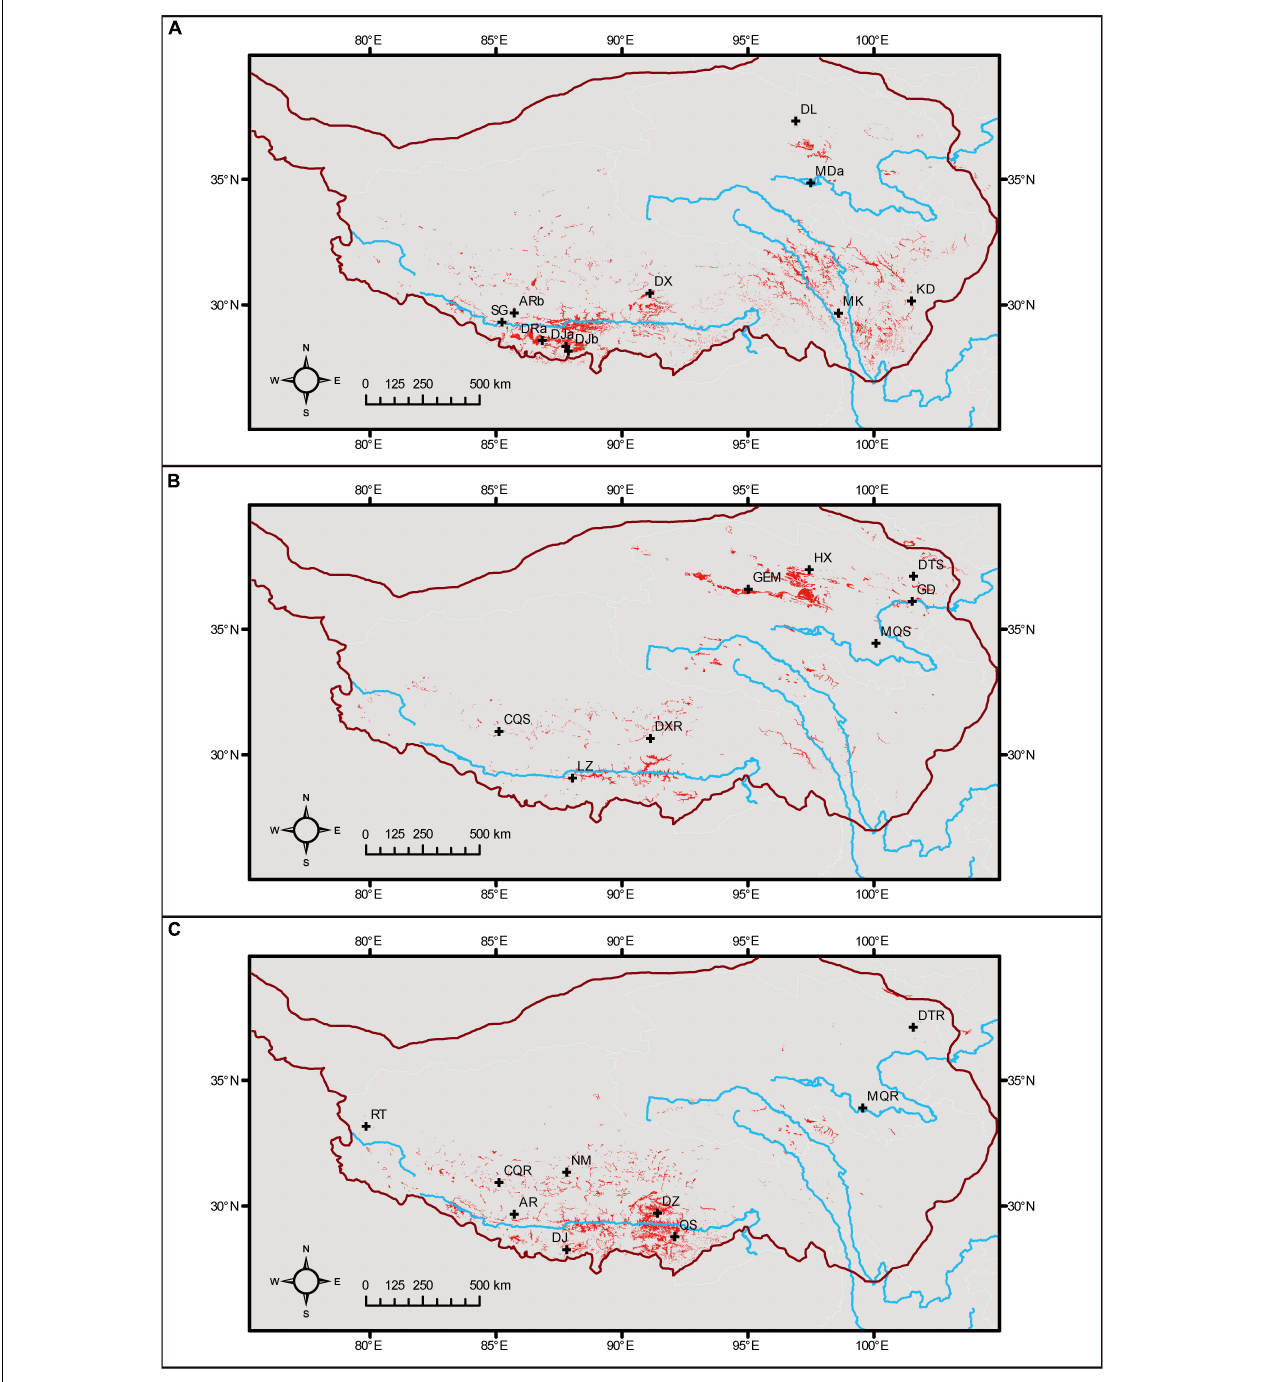
FIGURE 2 | Potential coexistence regions for related species, based on the presence in species distribution models. (A) Myriophyllum , (B) Stuckenia , and (C) Ranunculus . Sites of hybrid populations were plotted, and the boundary of the QTP is shown.